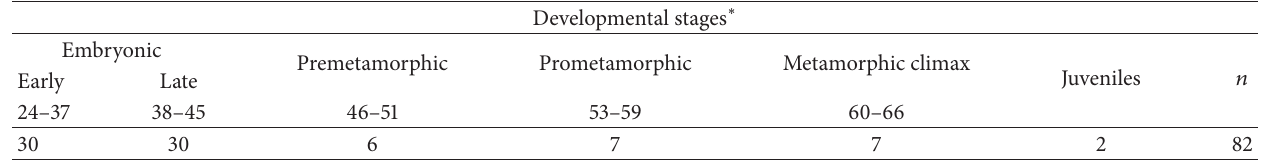
Figure 1: Stereomicroscope images of selected lateral views of Xenopus laevis tailbud embryos ((a)–(f)) and a dorsal view of a free-swimming tadpole (g) according to developmental stages (St) of Nieuwkoop and Faber [37]. Scale bars: 1mm. Table 1: Number of animals investigated at different stages of development with Isl1